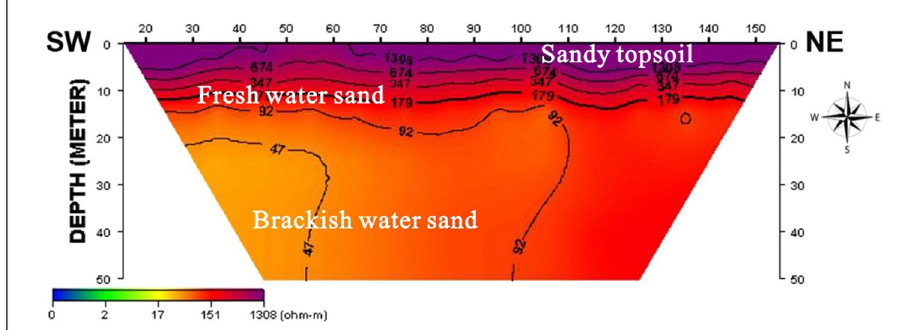
Fig. 10 Resistivity imaging of Traverse